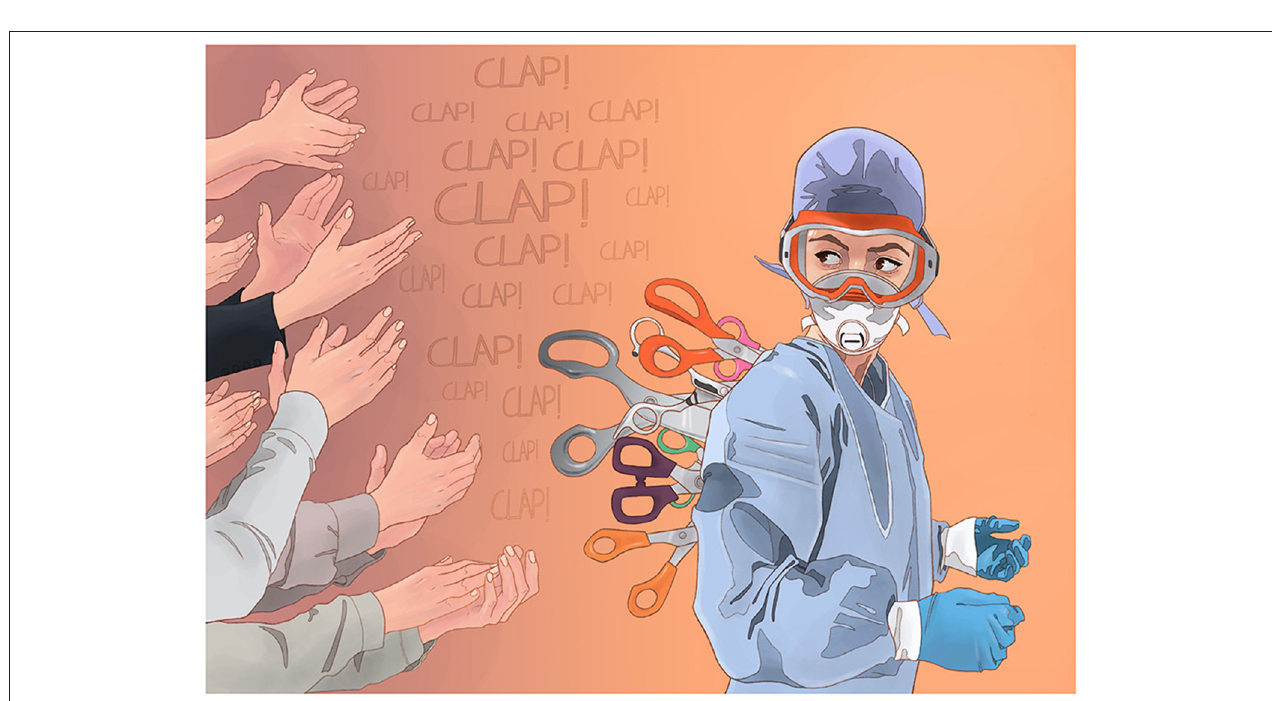
FIGURE 1 | Luis Quiles’ work “Expendable Workers” (ca. April 2020) depicting the contradiction in words and deeds perceived by frontline workers in Covid-19. Reproduced by kind permission of the artist.